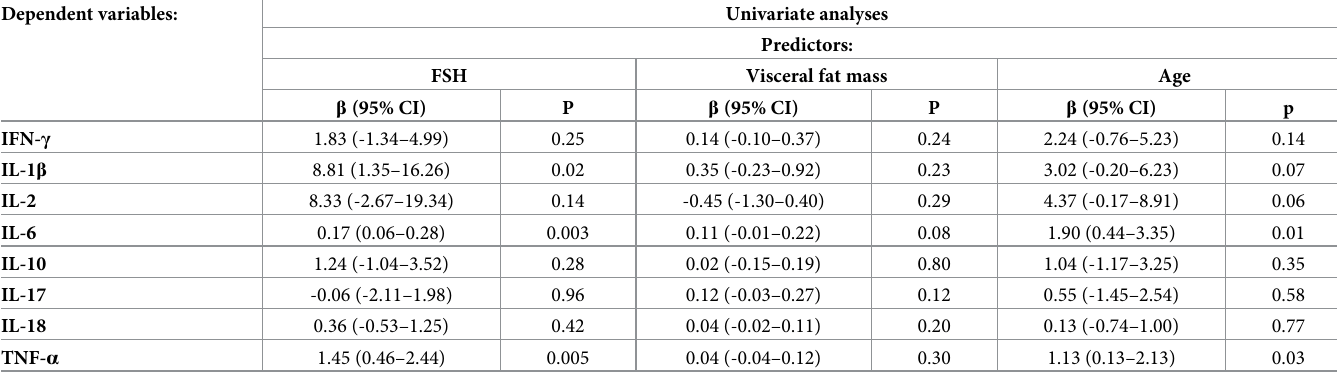
Table 5. Univariate regression analyses of predictors of plasma cytokine levels. Dependent variables: